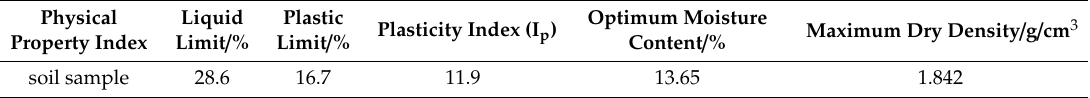
Table 1. Basic physical properties of undisturbed soil